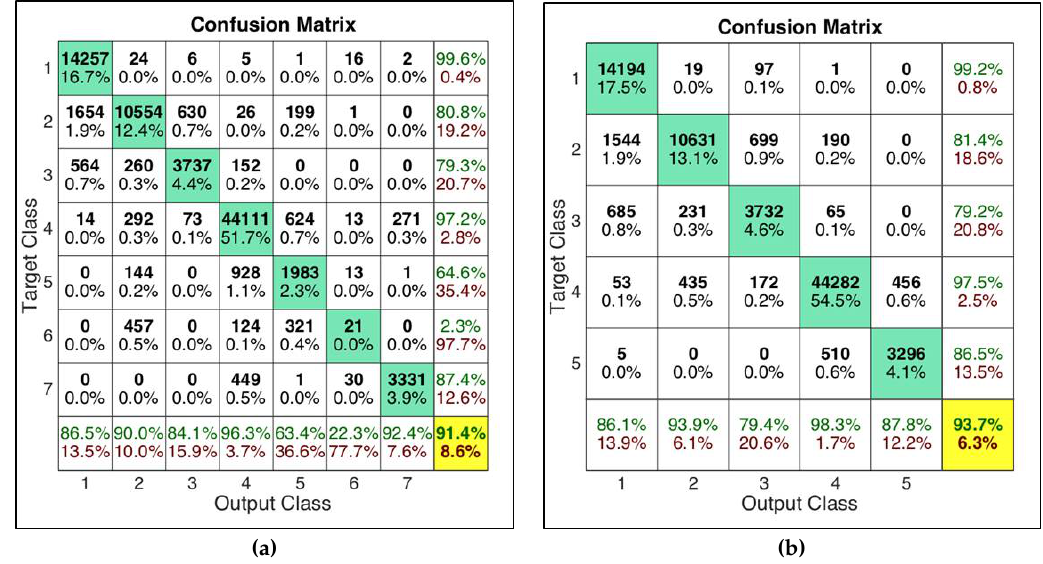
Figure 7. Confusion matrices of Neural Networks classification. ( a ) classification with 7 classes; ( b ) classification with 5